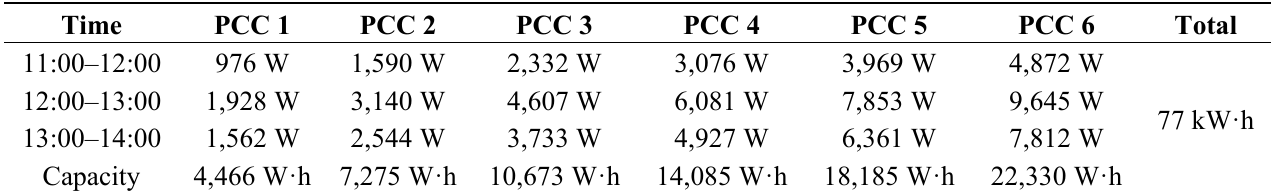
Table 5. ESSs charging schedule and capacity (case 4: most of the PVs are distributed on the middle